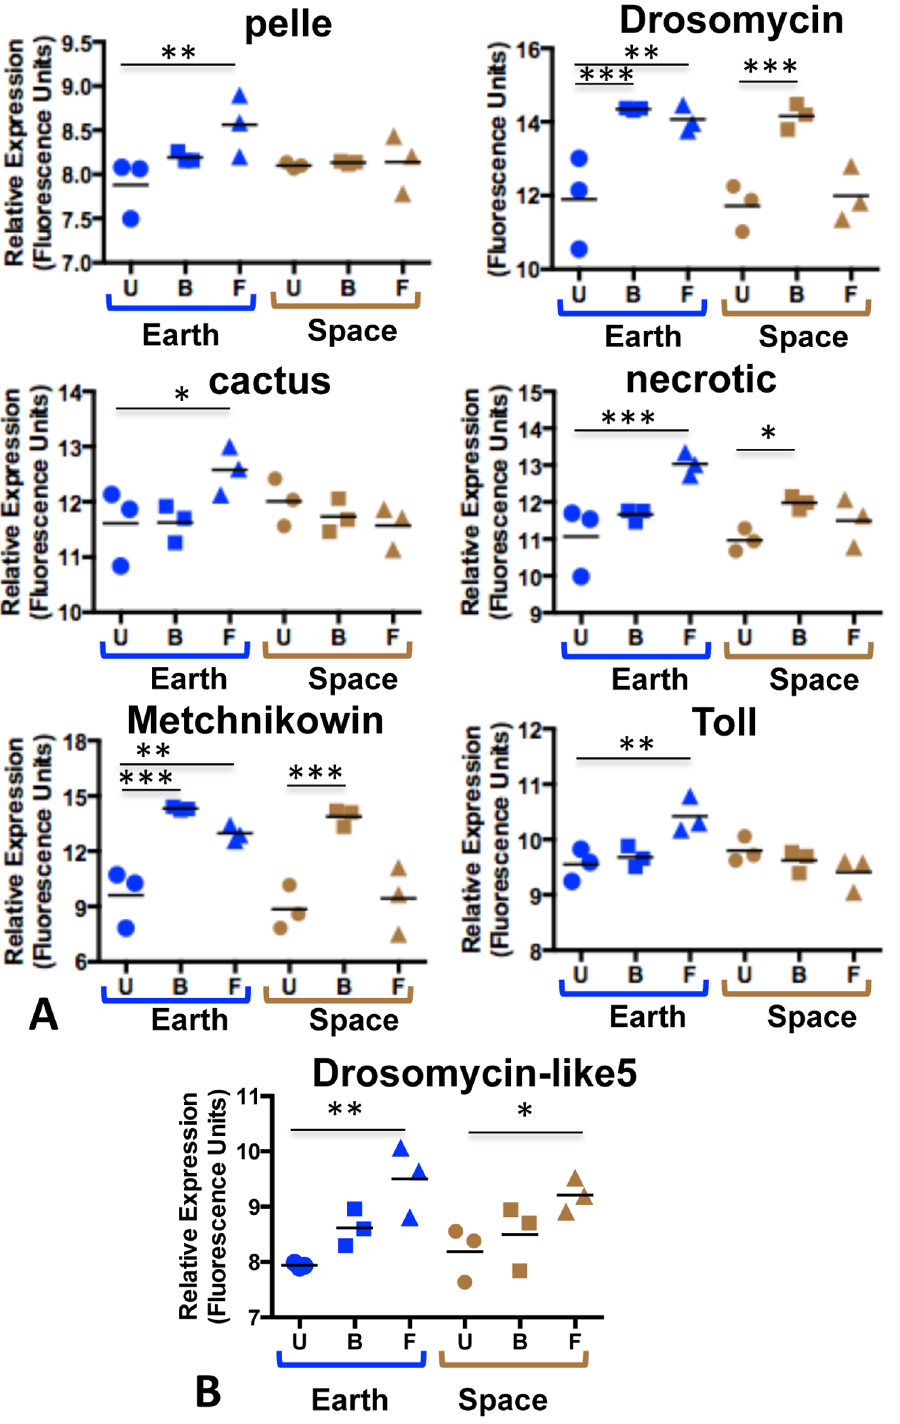
Figure 4. Transcriptional profiling of genes associated with the Toll pathway. Relative expression levels of selected Toll associated genes as detected by microarray are shown in uninfected (U, circles) Earth (blue) and space (tan) flies, and following fungal (F, triangles) or bacterial (B, squares) infection of space and Earth flies. Transcriptional regulation A. not shared or B. shared by space and earth flies infected with fungus. results are variable and a clear picture of heat shock protein involvement in these situations has not emerged [48,49,50,51].